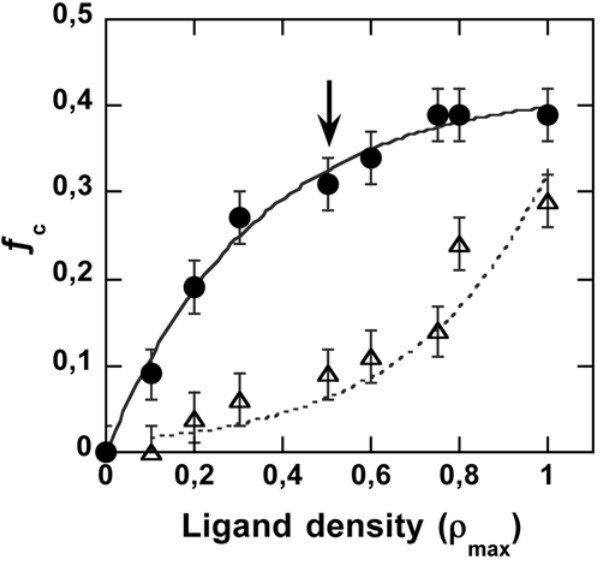
Figure 9. Anti-LFA-1 particle surface density variation. Fraction of particle-bearing cells as a function of anti-LFA-1 ligand density on the particle surface ( N ). Curve obtained with anti-CD3 particles at various surface densities was repeated for comparison ( D ). Conditions as in fig. 2.